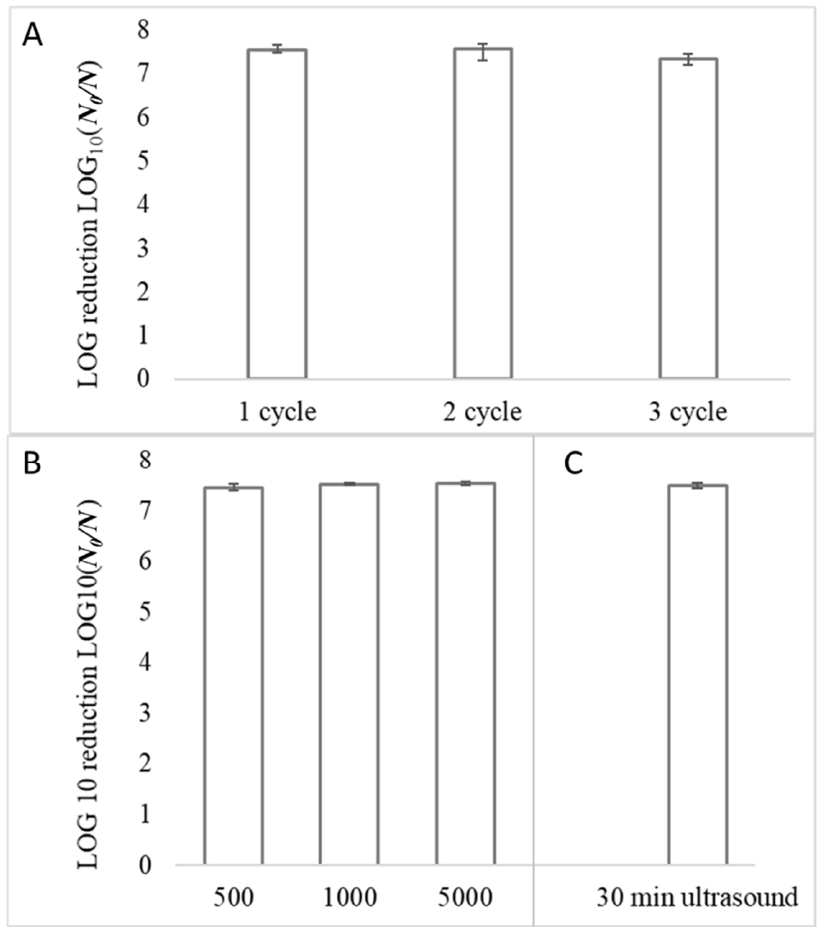
Figure 5. Reusability of EVA-Ag/AgCl/α-Fe 2 O 3 coating. S. aureus > 7-log reduction (full bacteria reduction) was obtained after 30 min of visible-light illumination in all 3 cycles ( A ). Additionally, S. aureus > 7-log reduction (full bacteria reduction) remained unchanged after coatings touching 500, 1000, and 5000 times ( B ), and 30 min ultrasound washing ( C ) after 30 min of visible-light illumination. The mean value of 2 repetitions with 3 samples in each (cycles) and 3 repetitions ± standard deviation (SD) is reported.